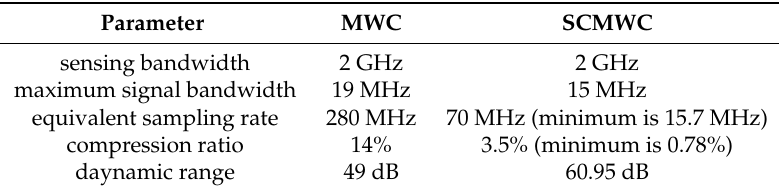
Table 2. Performance Comparisons between MWC and SCMWC.